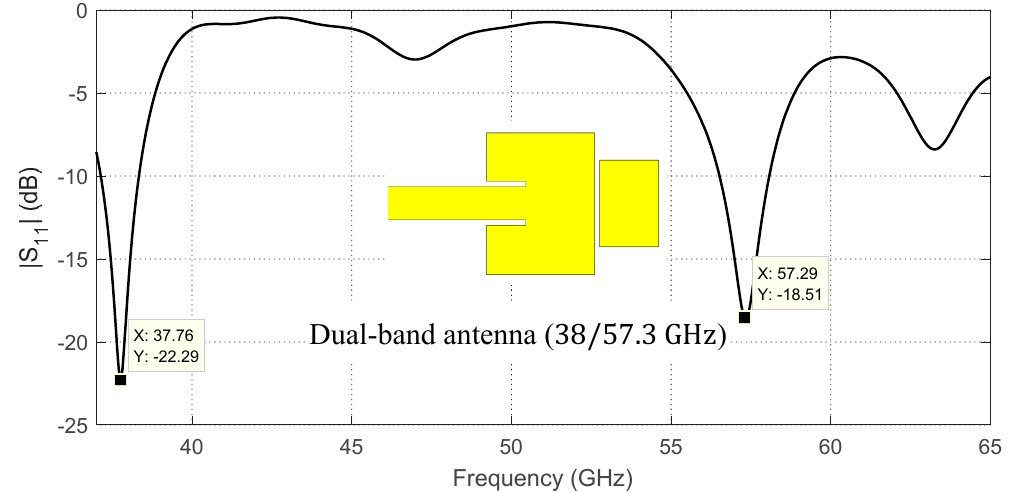
Figure 2. Simulated dependence of the return loss, | S 11 | , on the frequency over a wide band of the frequency for the indicated dual-patch antenna (initial design).